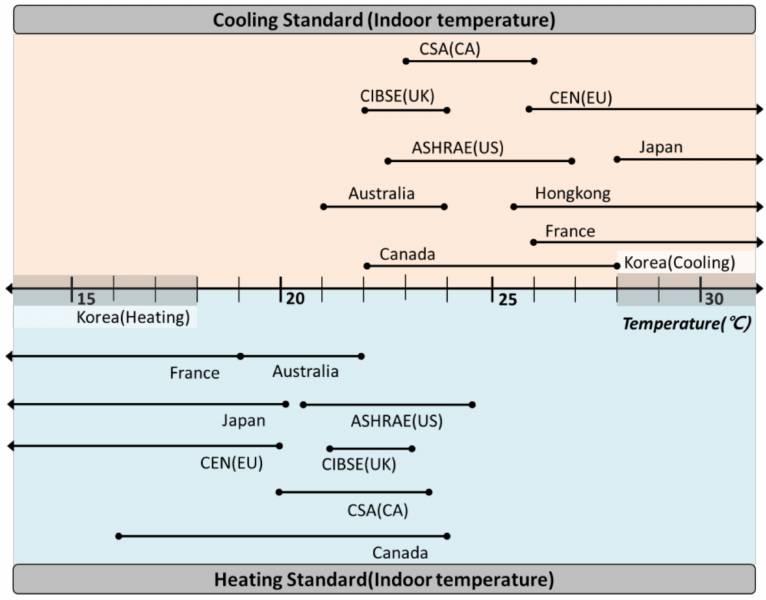
Figure 1. Standard for heating and cooling temperature of o ffi ce facilities in major